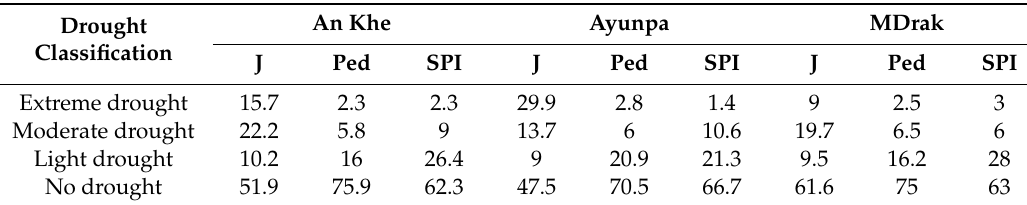
Table 5. The drought classification frequency (%), with the J, SPI, and Ped indices.